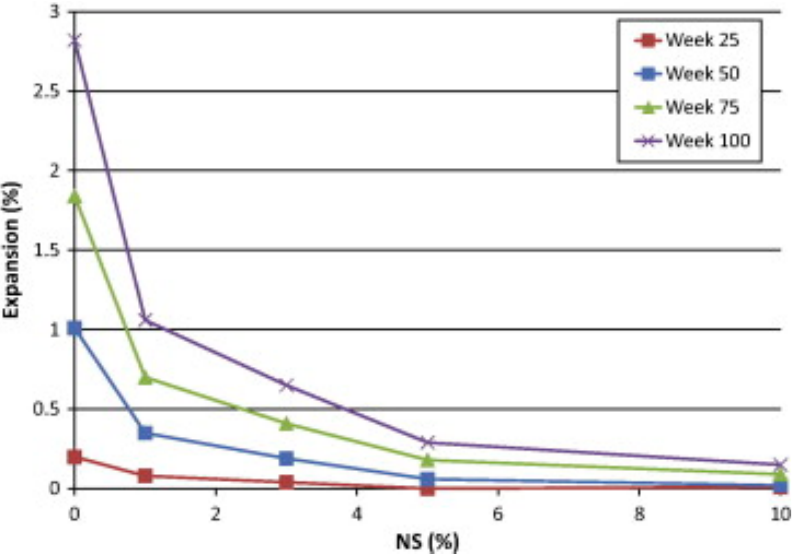
Figure 12. Influence of nano-silica addition on sulphate resistance of cementitious materials